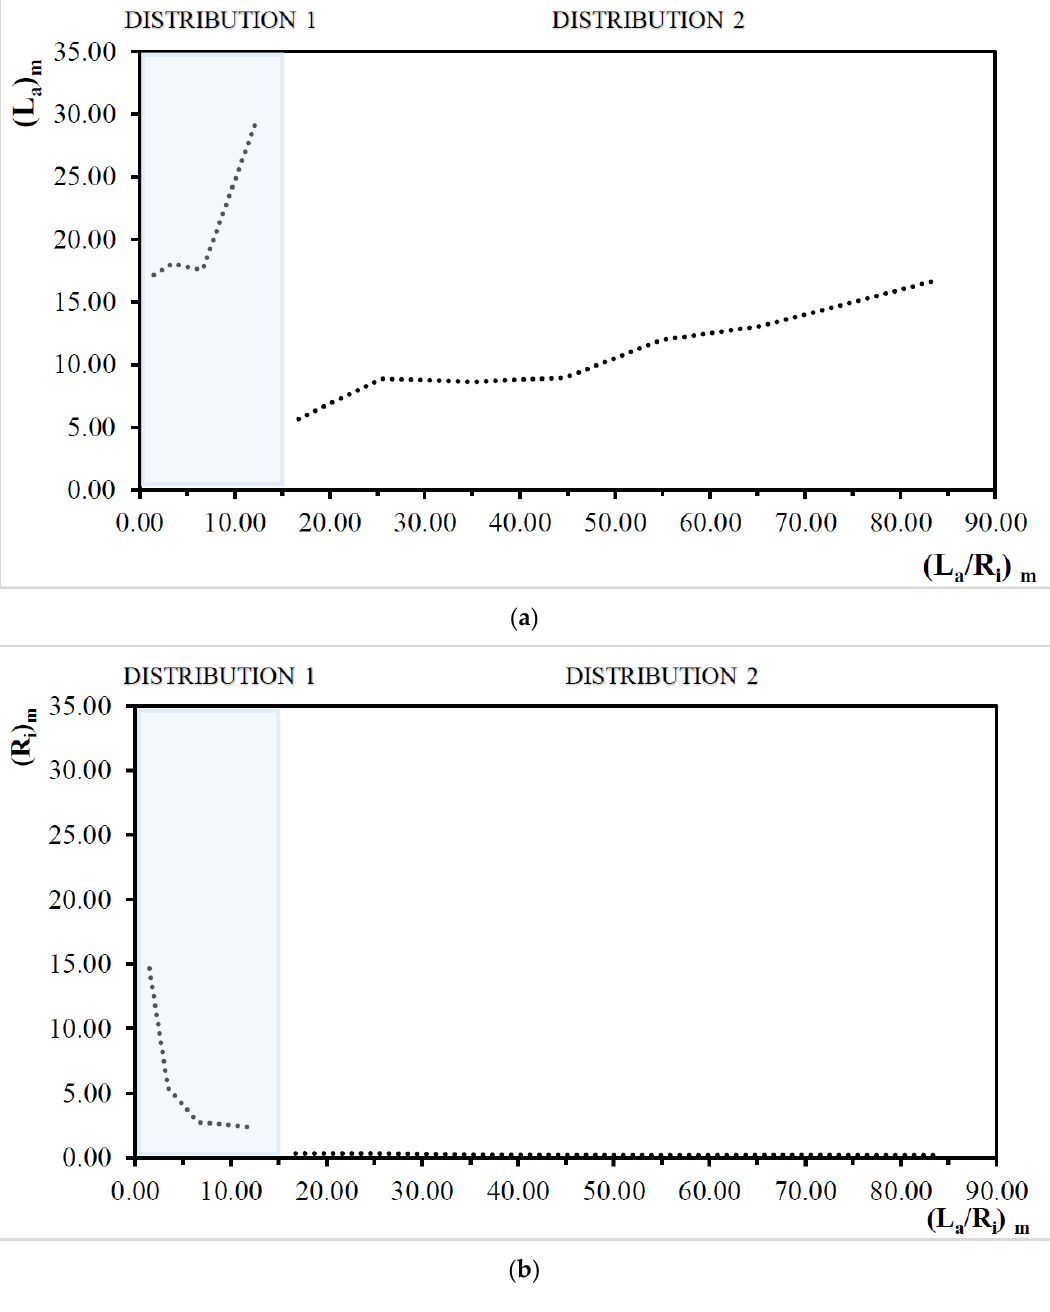
Figure 10. Trends of (L a ) m ( a ) and (R i ) m ( b ) for each distribution.